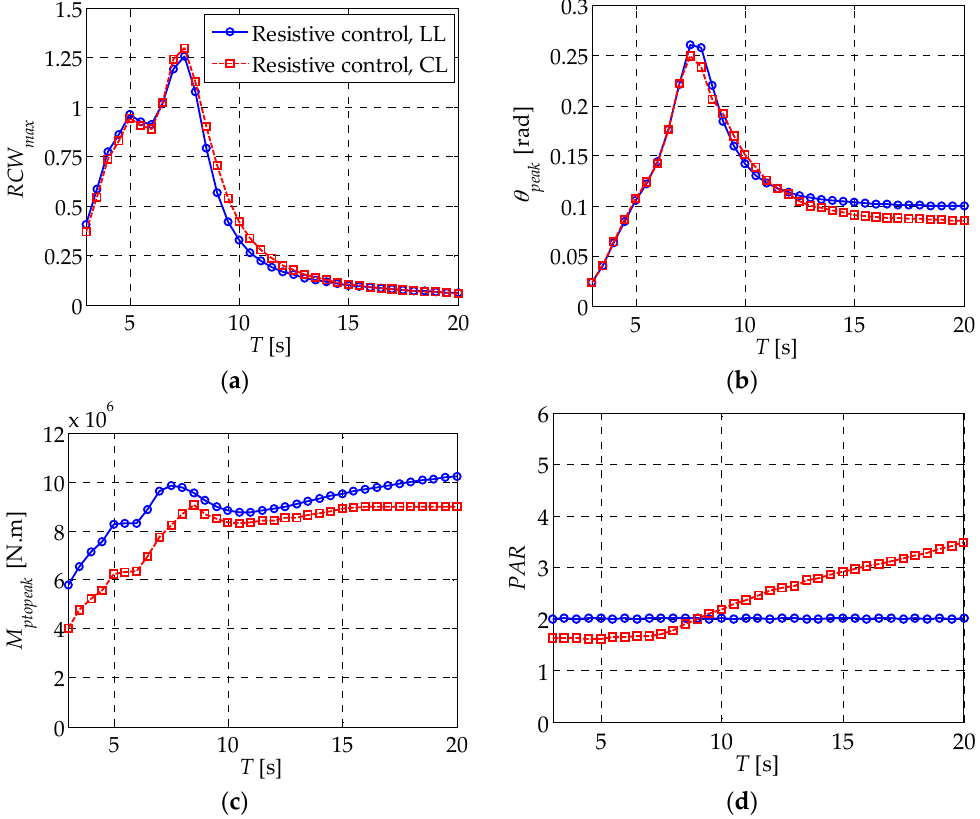
Figure 5. Performance of the solo duck WEC as a function of the wave period for different load types when relative capture width is maximized under resistive control: ( a ) maximum relative capture width; ( b ) peak motion excursion; ( c ) peak power take-off (PTO) moment; ( d ) peak-to-average power ratio.